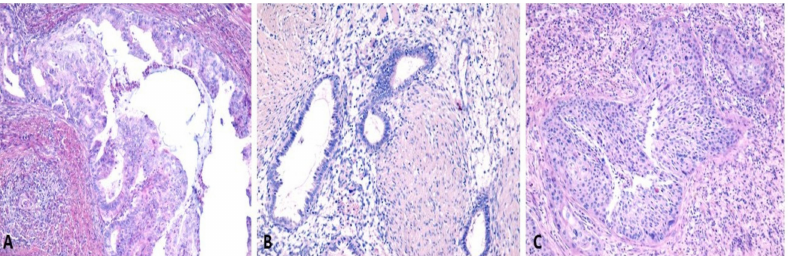
Figure 3. ( A – C )—Hyperplastic and neoplastic transformations of ectopic endometrial foci. ( A , B ) An outbreak of hyperplastic transformed adenomyosis with atypical cellularity. The nucleocytoplasmic ratio is reversed, and the nuclei are hypochromic. The cells of the endometrial glands are organized in several layers. Intramiometrial periglandular stroma is loose, [ × 100]; ( C ) Moderately differentiated G2 endometrioid carcinoma area, coexisting with underlying areas of endometriosis, some with hyperplasia with and without atypia, [ × 200]; classic histological staining HE. HE: Hematoxylin-Eosin.